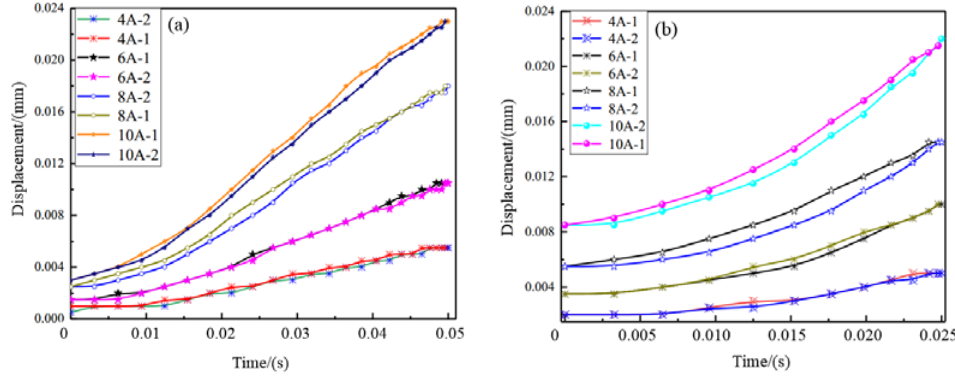
Figure 21. Hysteresis loop tests: ( a ) 10 Hz sinusoidal excitation, ( b ) 20 Hz sinusoidal excitation.